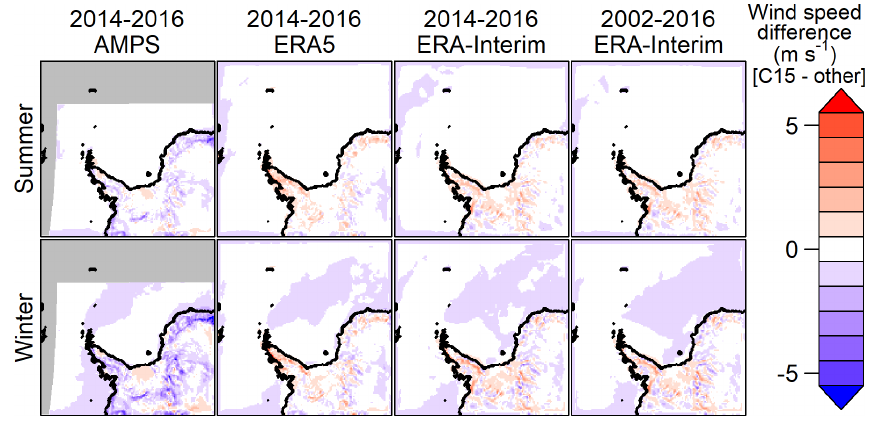
Figure 5. As Fig. 3 but for 10m wind speed.